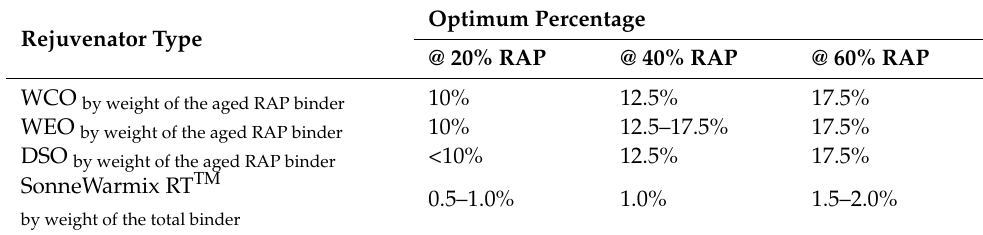
Table 22. The optimum percentages of the used